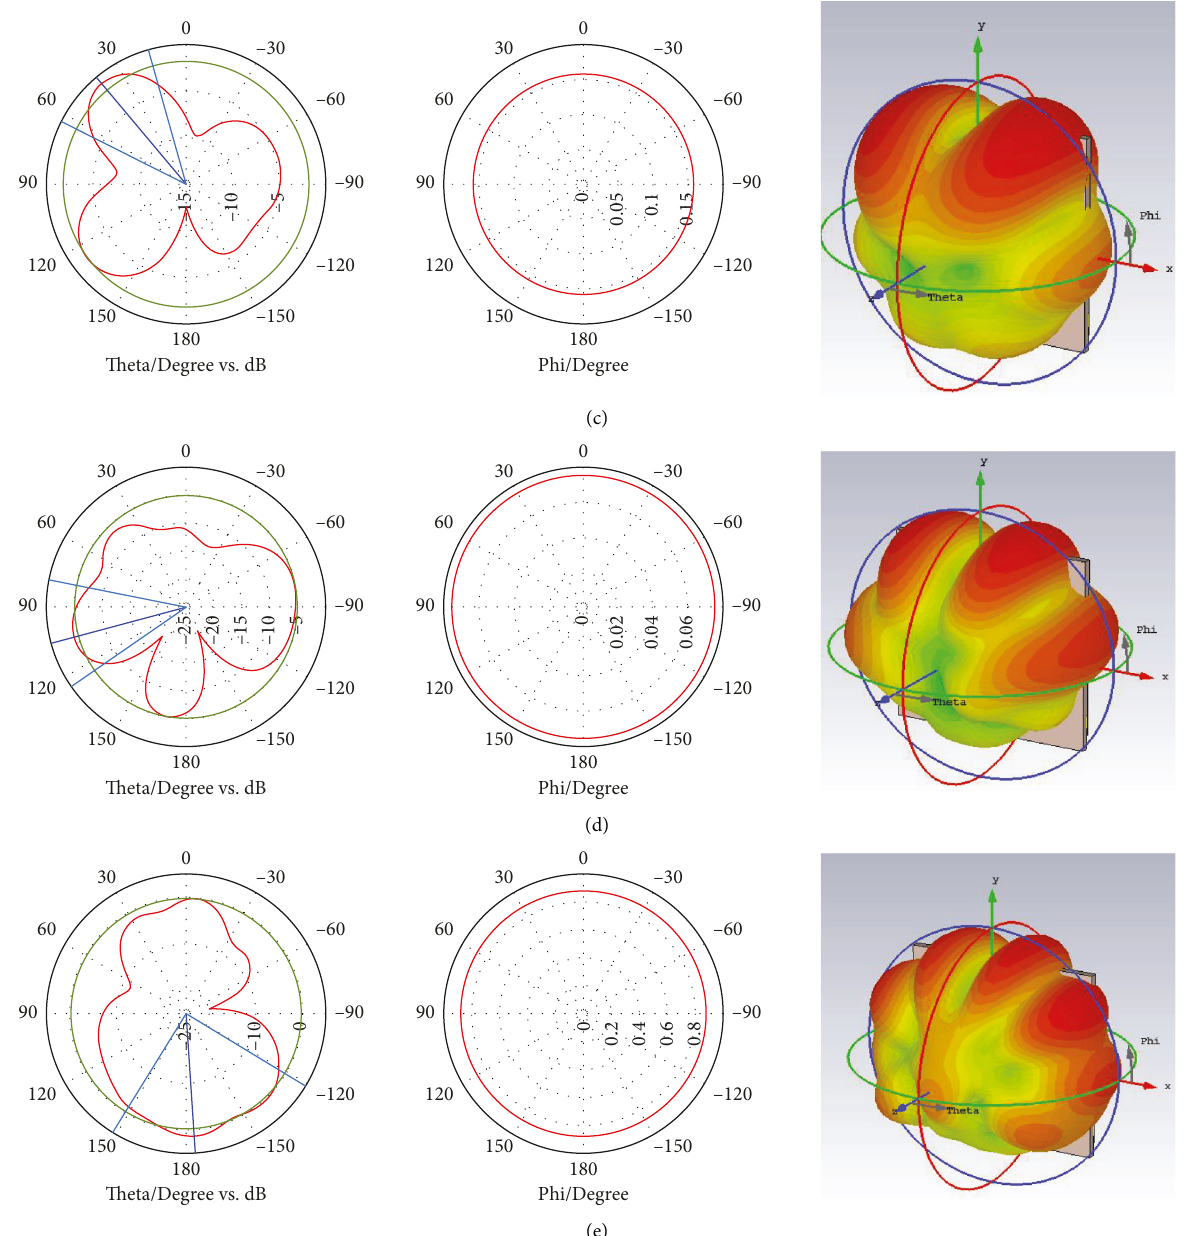
Figure 8: Radiation pattern at various resonating frequencies: (a) 2.64GHz. (b) 4.87 GHz. (c) 7.86GHz. (d) 10.74GHz. (e)